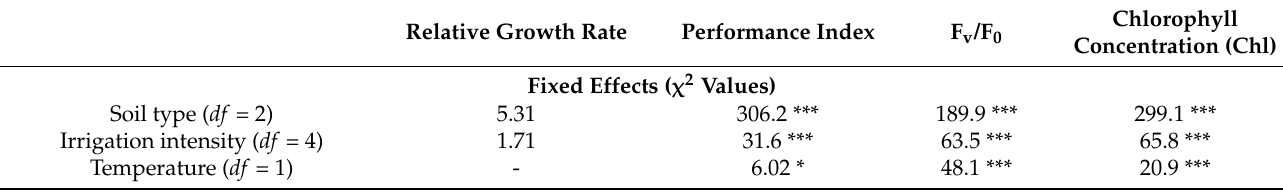
Table 4. The effect ( χ 2 values) of soil type, irrigation intensity, air temperature, atmospheric vapour pressure deficit, and soil water potential on weekly relative growth rate, photosynthetic performance index, F v /F 0 ratio, and chlorophyll concentration in the second-year needles of the third-year seedlings of Norway spruce. The asterisks denote statistical significance ( p -values) of the effects: * <0.05, ** <0.01, and *** <0.001. df : degree of freedom.